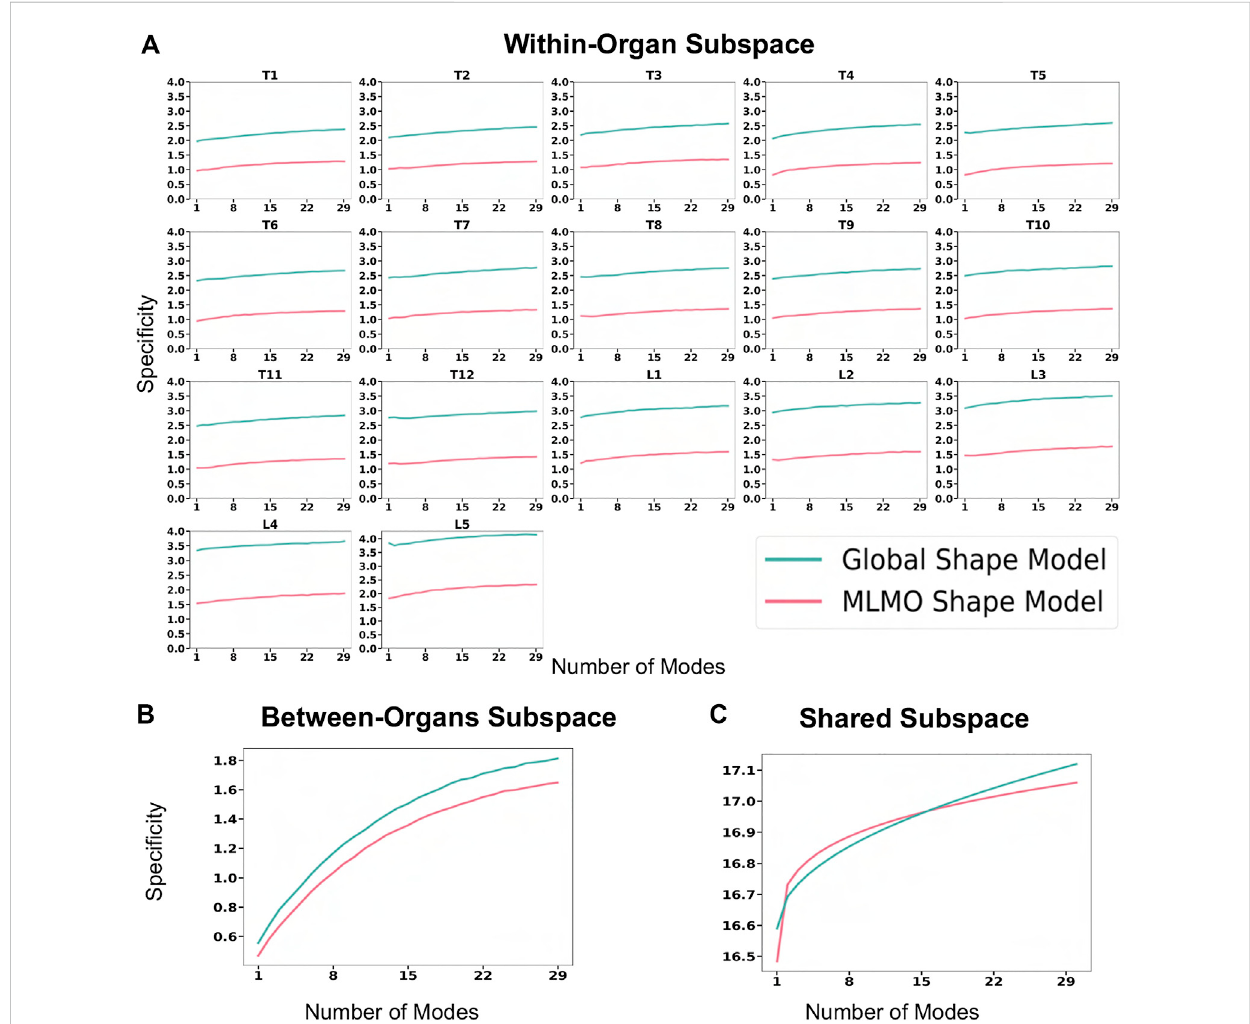
FIGURE 7 Speci fi city (in mm ) for spinal column data — (A) within-organ subspace. (B) Between-organs subspace. (C) Shared